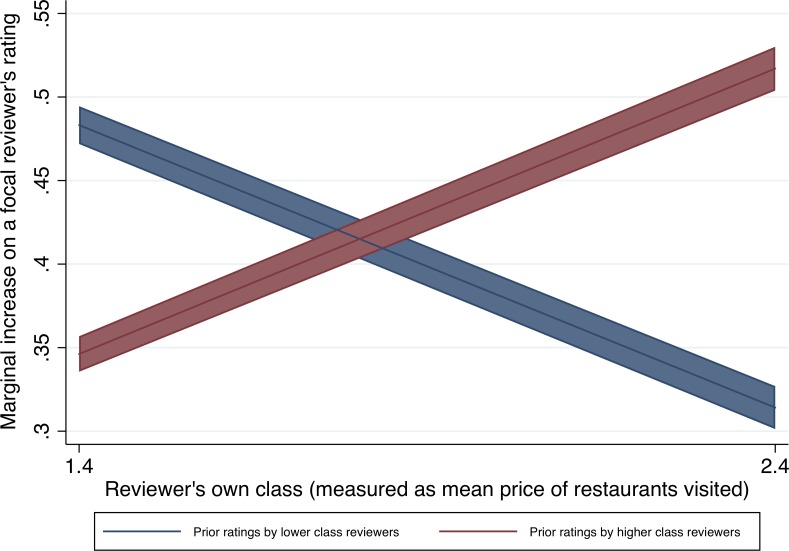
Study 1: Marginal increase on a focal reviewer’s rating predicted by prior ratings by higher- and lower-class reviewers as a function of the focal reviewer’s own class.Based on Model 4 in Table 2. The lines represent linear regression estimates, the shaded areas show the 95% confidence intervals.